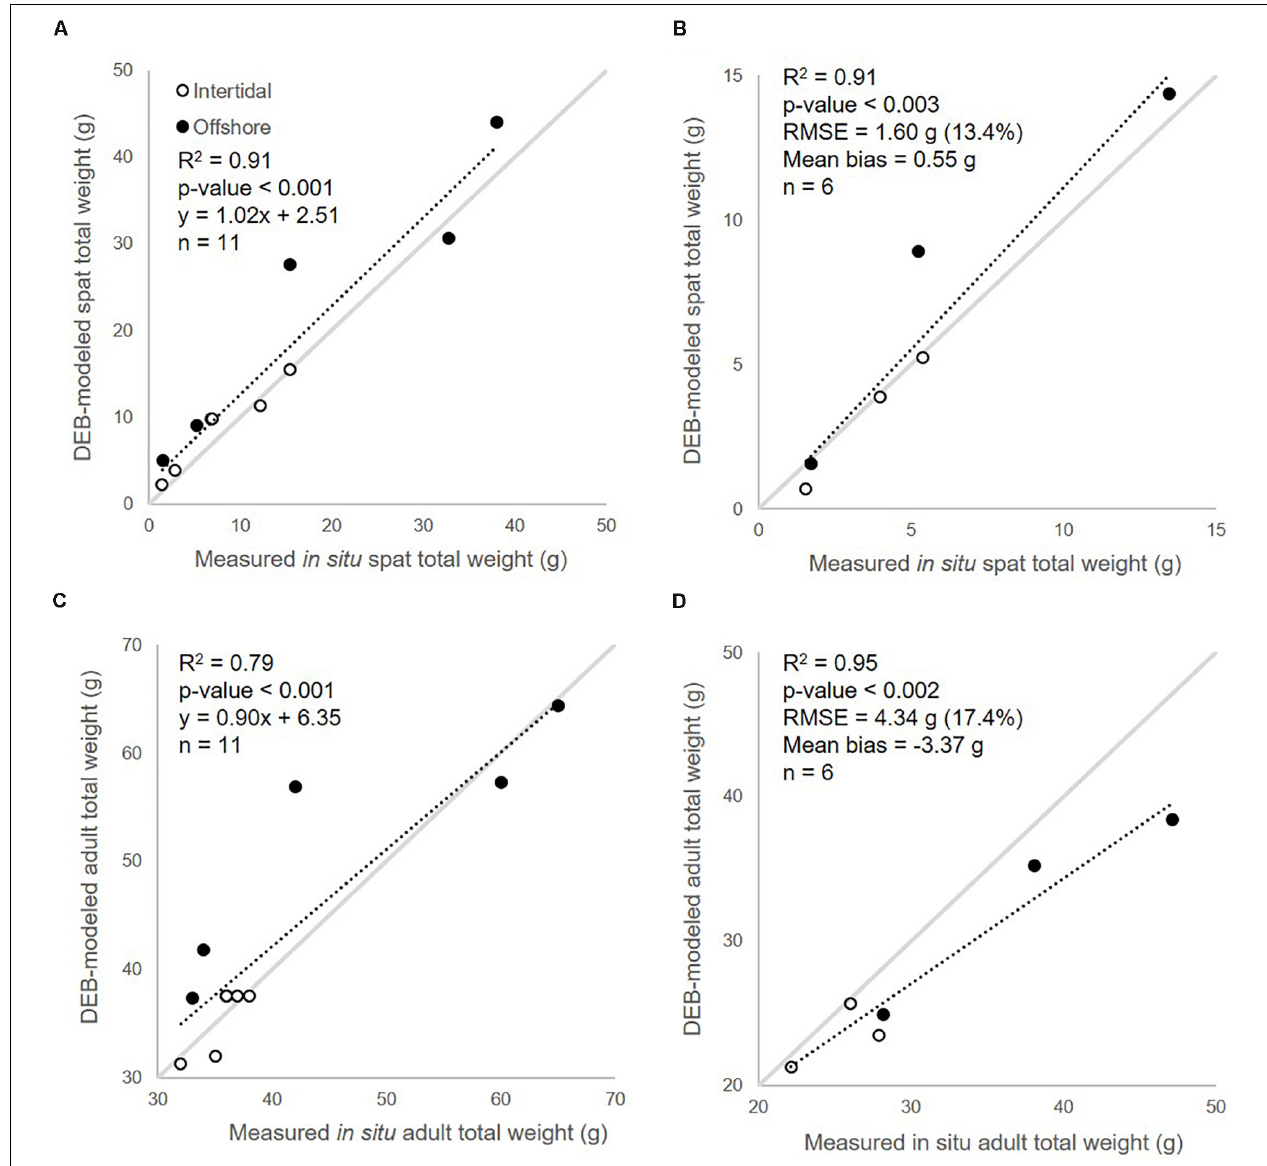
FIGURE 6 | Calibration of DEB-modeled (A) spat and (C) adult growth using corresponding 2010 in situ data from intertidal and offshore zones; validation for spat (B) and adult (D) growth modeled with calibrated coefficients using in situ data from 2008 (see Figure 1 for sampling